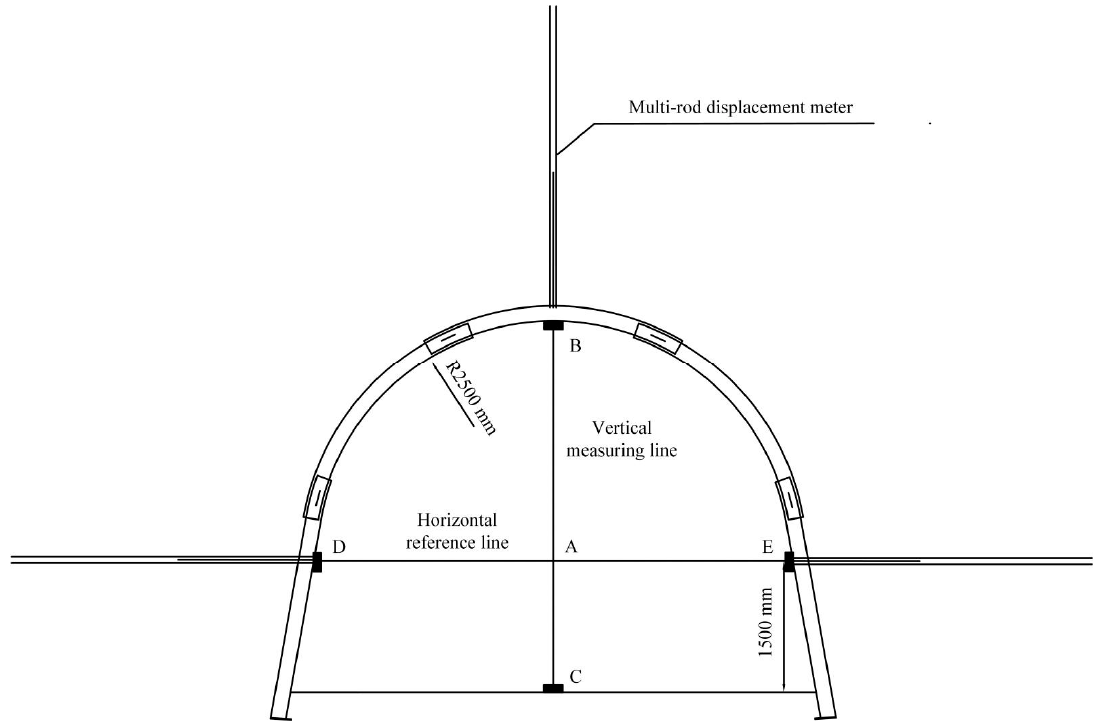
Figure 13. Monitoring layout of multi-point displacement and surface displacement.